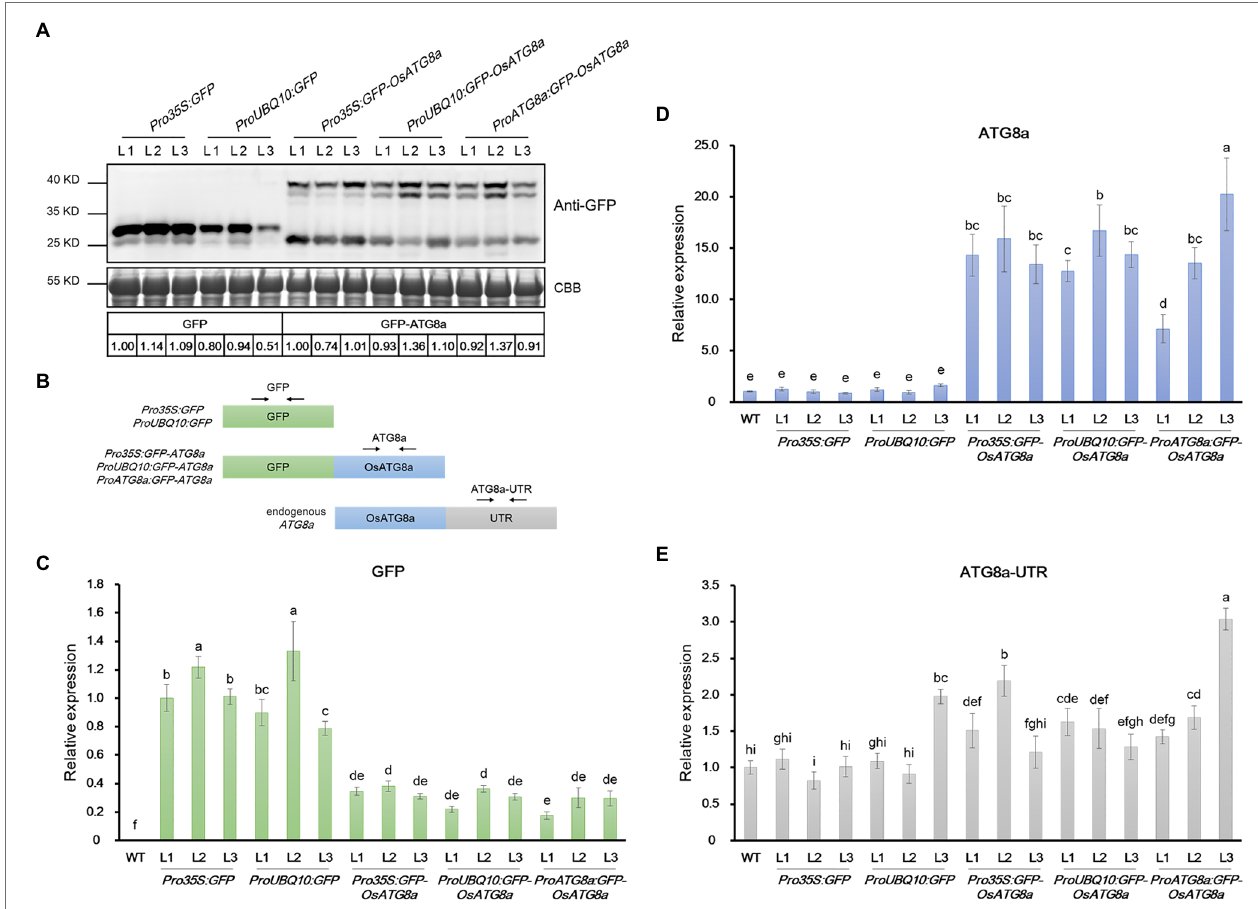
FIGURE 4 | mRNA and protein levels of GFP and GFP-OsATG8a in rice transgenic lines. (A) Expression of GFP (27 kD) and GFP-OsATG8a (40 kD, one or two bands) were detected by immunoblotting and quantified by ImageJ. The protein level of GFP was normalized to Pro35S:GFP —L1 (set as 1), and the level of GFP- OsATG8a was normalized to Pro35S:GFP-OsATG8a —L1 (set as 1). Three T2 transgenic lines for each construct were shown. Coomassie Blue staining of RuBisCO large subunit was used as loading control. Three biological replicates were done, and one representative replicate is shown. (B) Schematic representation of the primers designed for qRT-PCR in (C–E) . (C–E) qRT-PCR analysis of transgenic seedlings. Transcript levels of (C) GFP , (D) OsATG8a , and (E) OsATG8a-UTR were profiled and normalized to the Pro35S:GFP —L1 (C) or the wild-type control (D,E) . Data are means ± SD ( n = 4), one-way ANOVA followed by Tukey B test; p = 0.05. Different letters denote significant differences. Three biological replicates, each consisting of four technical repeats, were done, and one representative replicate is